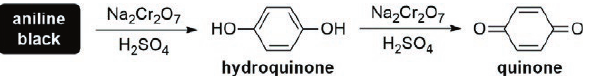
Figure 3. Nietzki’s proposed oxidative degradation of aniline